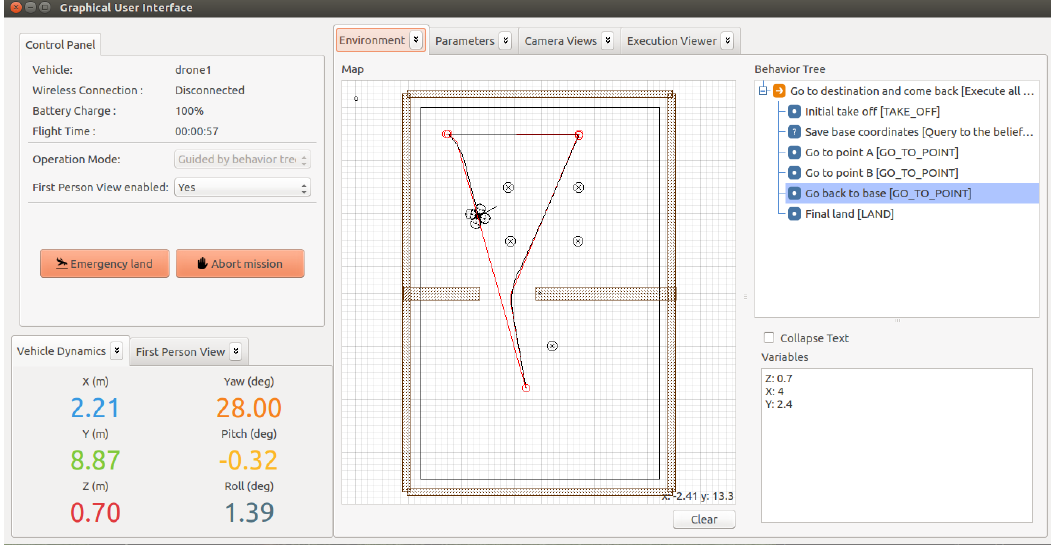
Figure 8. Example of screen presented by the graphical user interface of Aerostack to execute and supervise a mission plan.